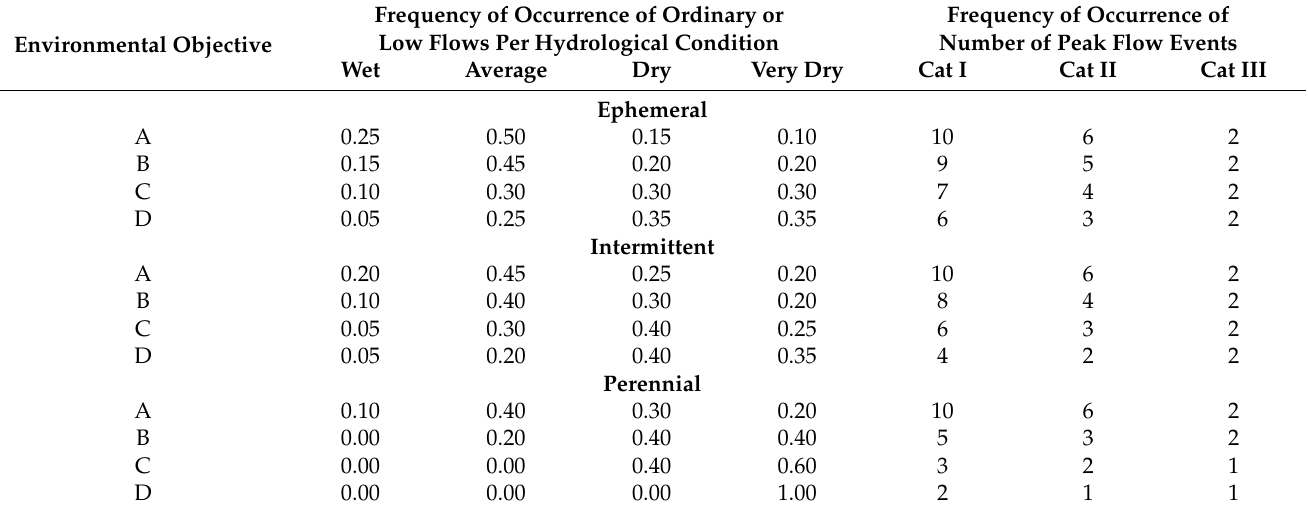
Table 1. Frequency factors of occurrence per environmental objective class for the integration of the ordinary or low flows and flood regime (Cat = categories of peak flow events at 1-, 1.5-, and 5-year return period) components into annual volumes for environmental water allocation for perennial rivers, and adjustment for ephemeral streams and intermittent